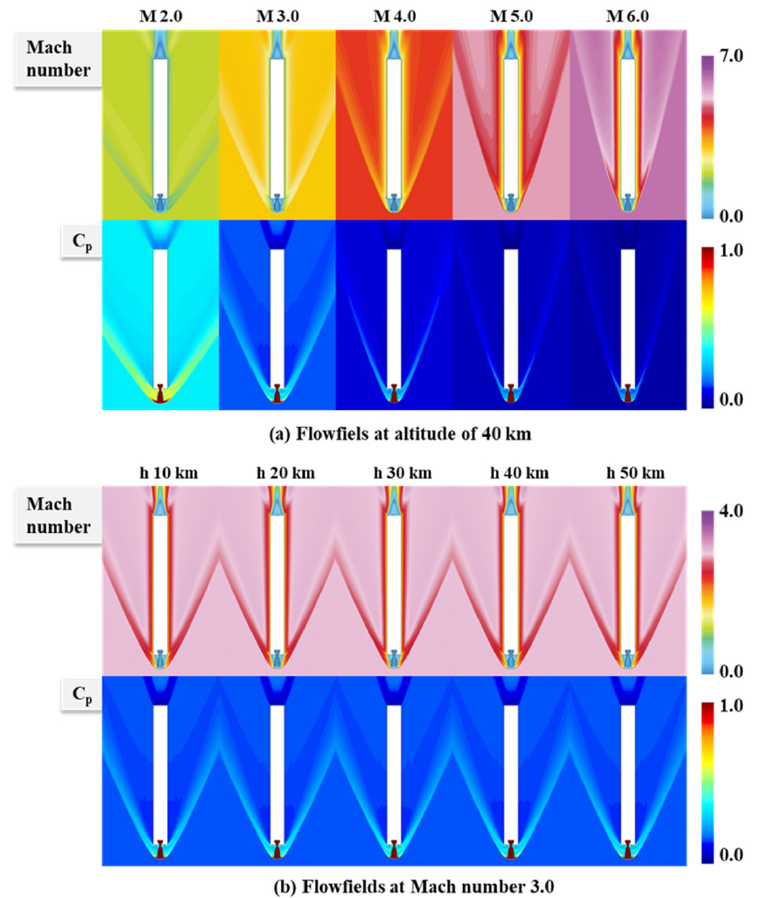
Figure 8. Mach number and pressure coefficient contour in the free-fall flight phase. ( a ) Flowfields at altitude of 40 km; ( b ) Flowfields at Mach number of 3.0.